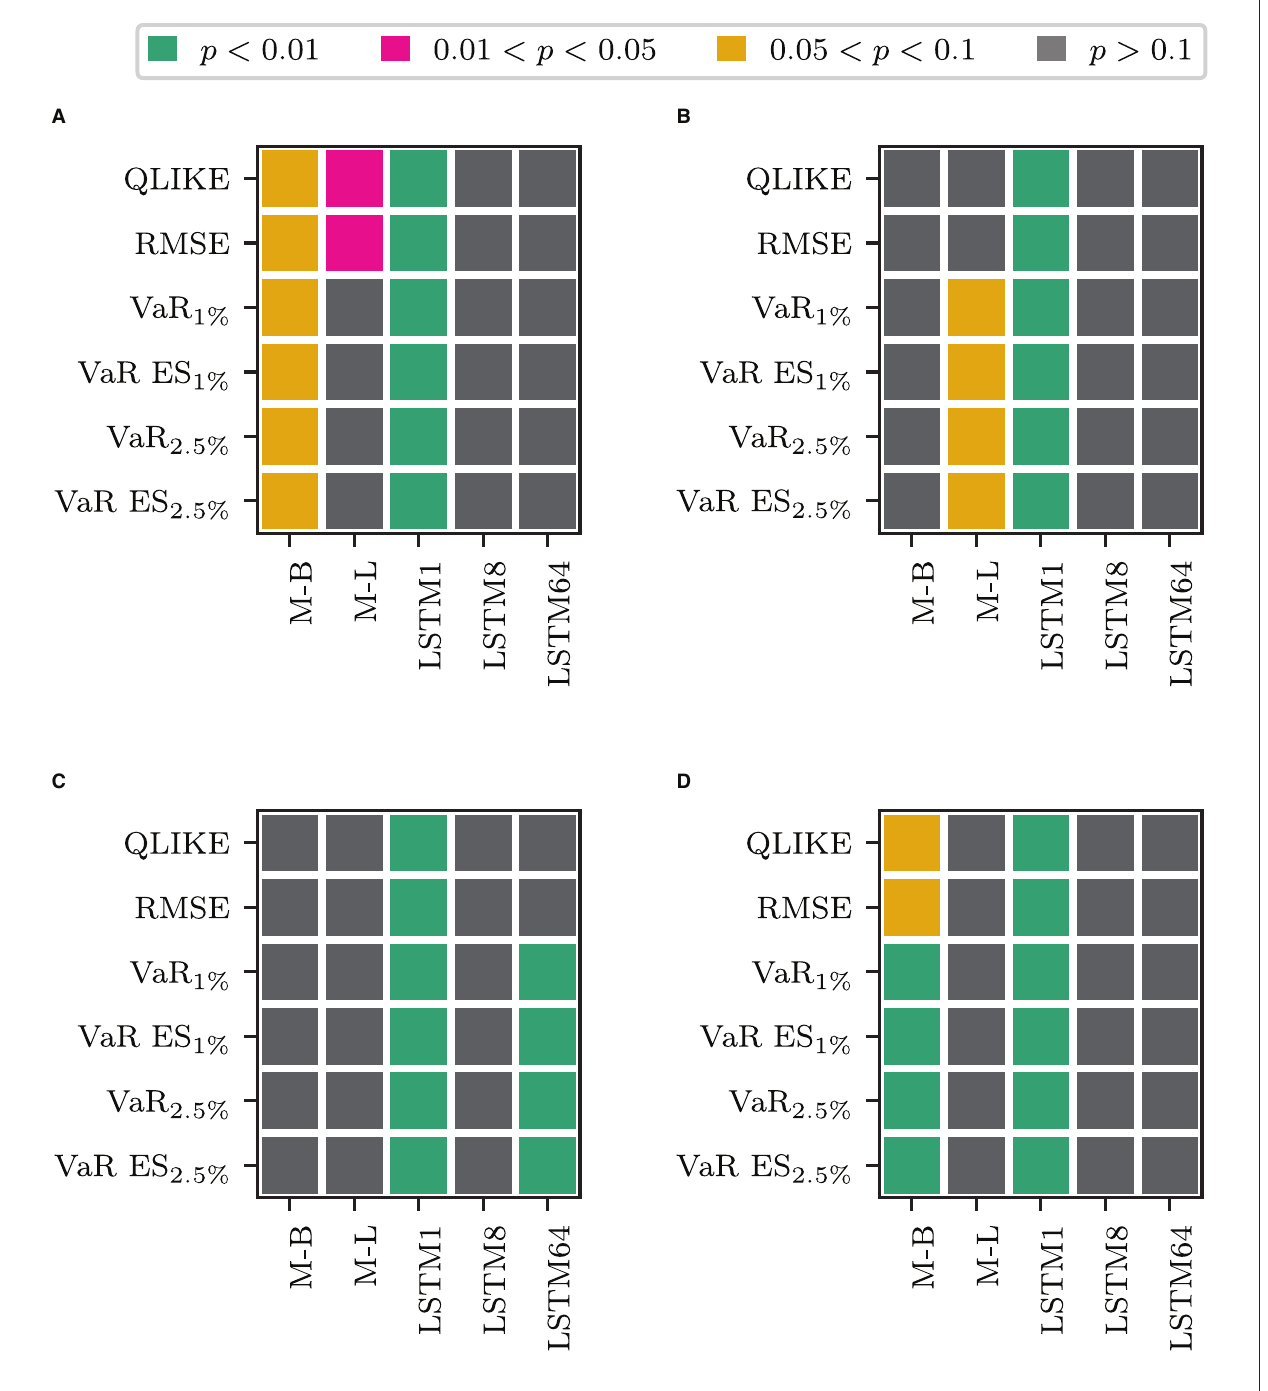
FIGURE 4 | Results for a Binomial test of equal forecasting performance between the models combine the transformed measure and their counterpart that does not use the transformed measure. (A) HAR-F vs. HAR O . (B) HAR vs. HAR O . (C) LSTM-F vs. LSTM O . (D) LSTM vs. LSTM O .